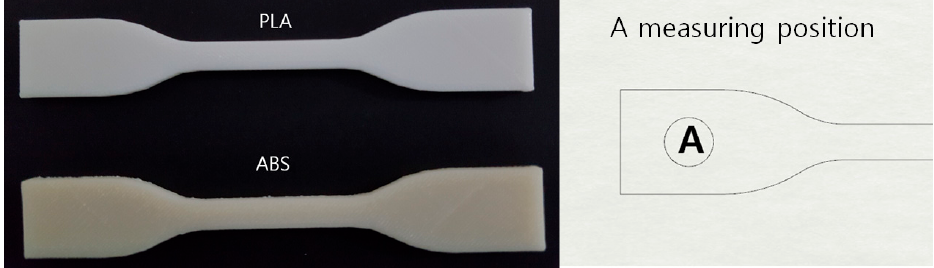
Figure 2. Polylactic acid (PLA) and acrylonitrile butadiene styrene (ABS) specimens fabricated by 3D printers and the measuring position for the Fourier transform infrared (FTIR) method.